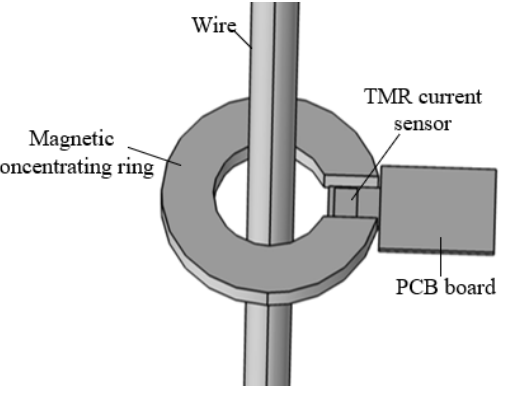
Figure 5. Leakage current measurement.